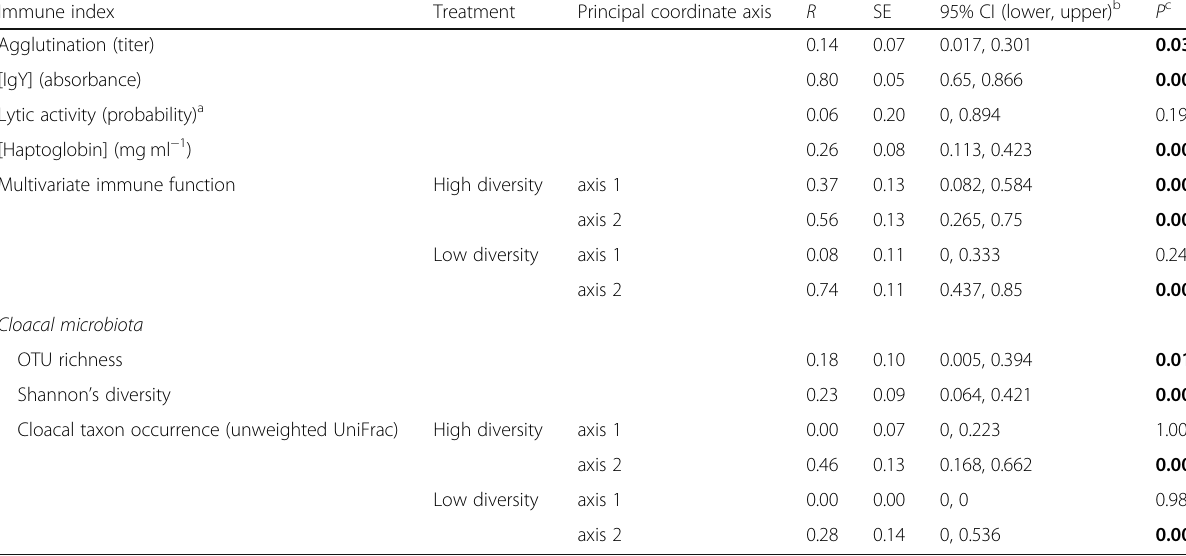
Table 2 Repeatability of innate immune indices and cloacal microbiota characteristics of female zebra finches Immune index Treatment